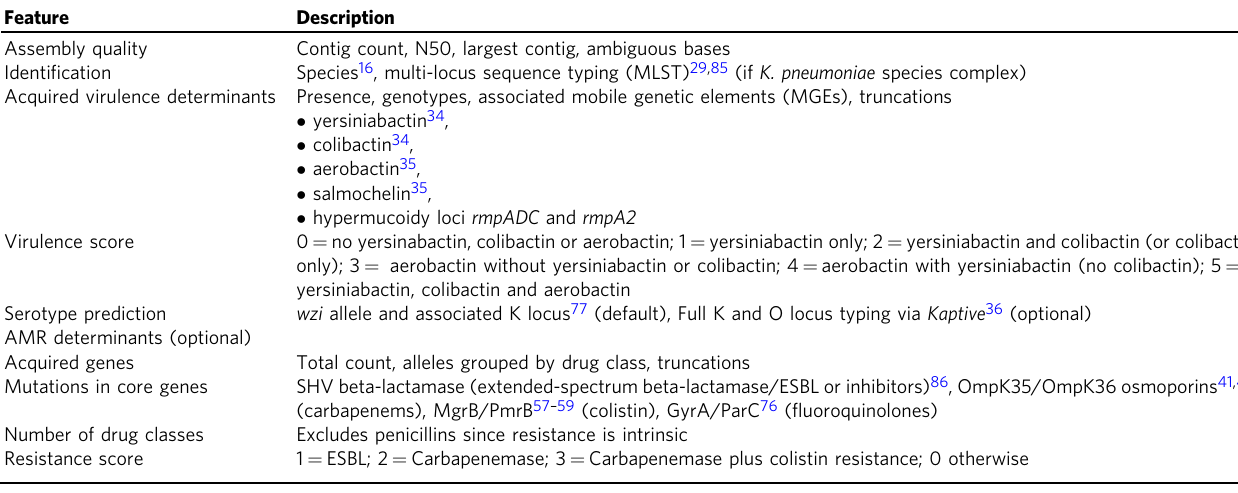
Table 1 Genome features reported by